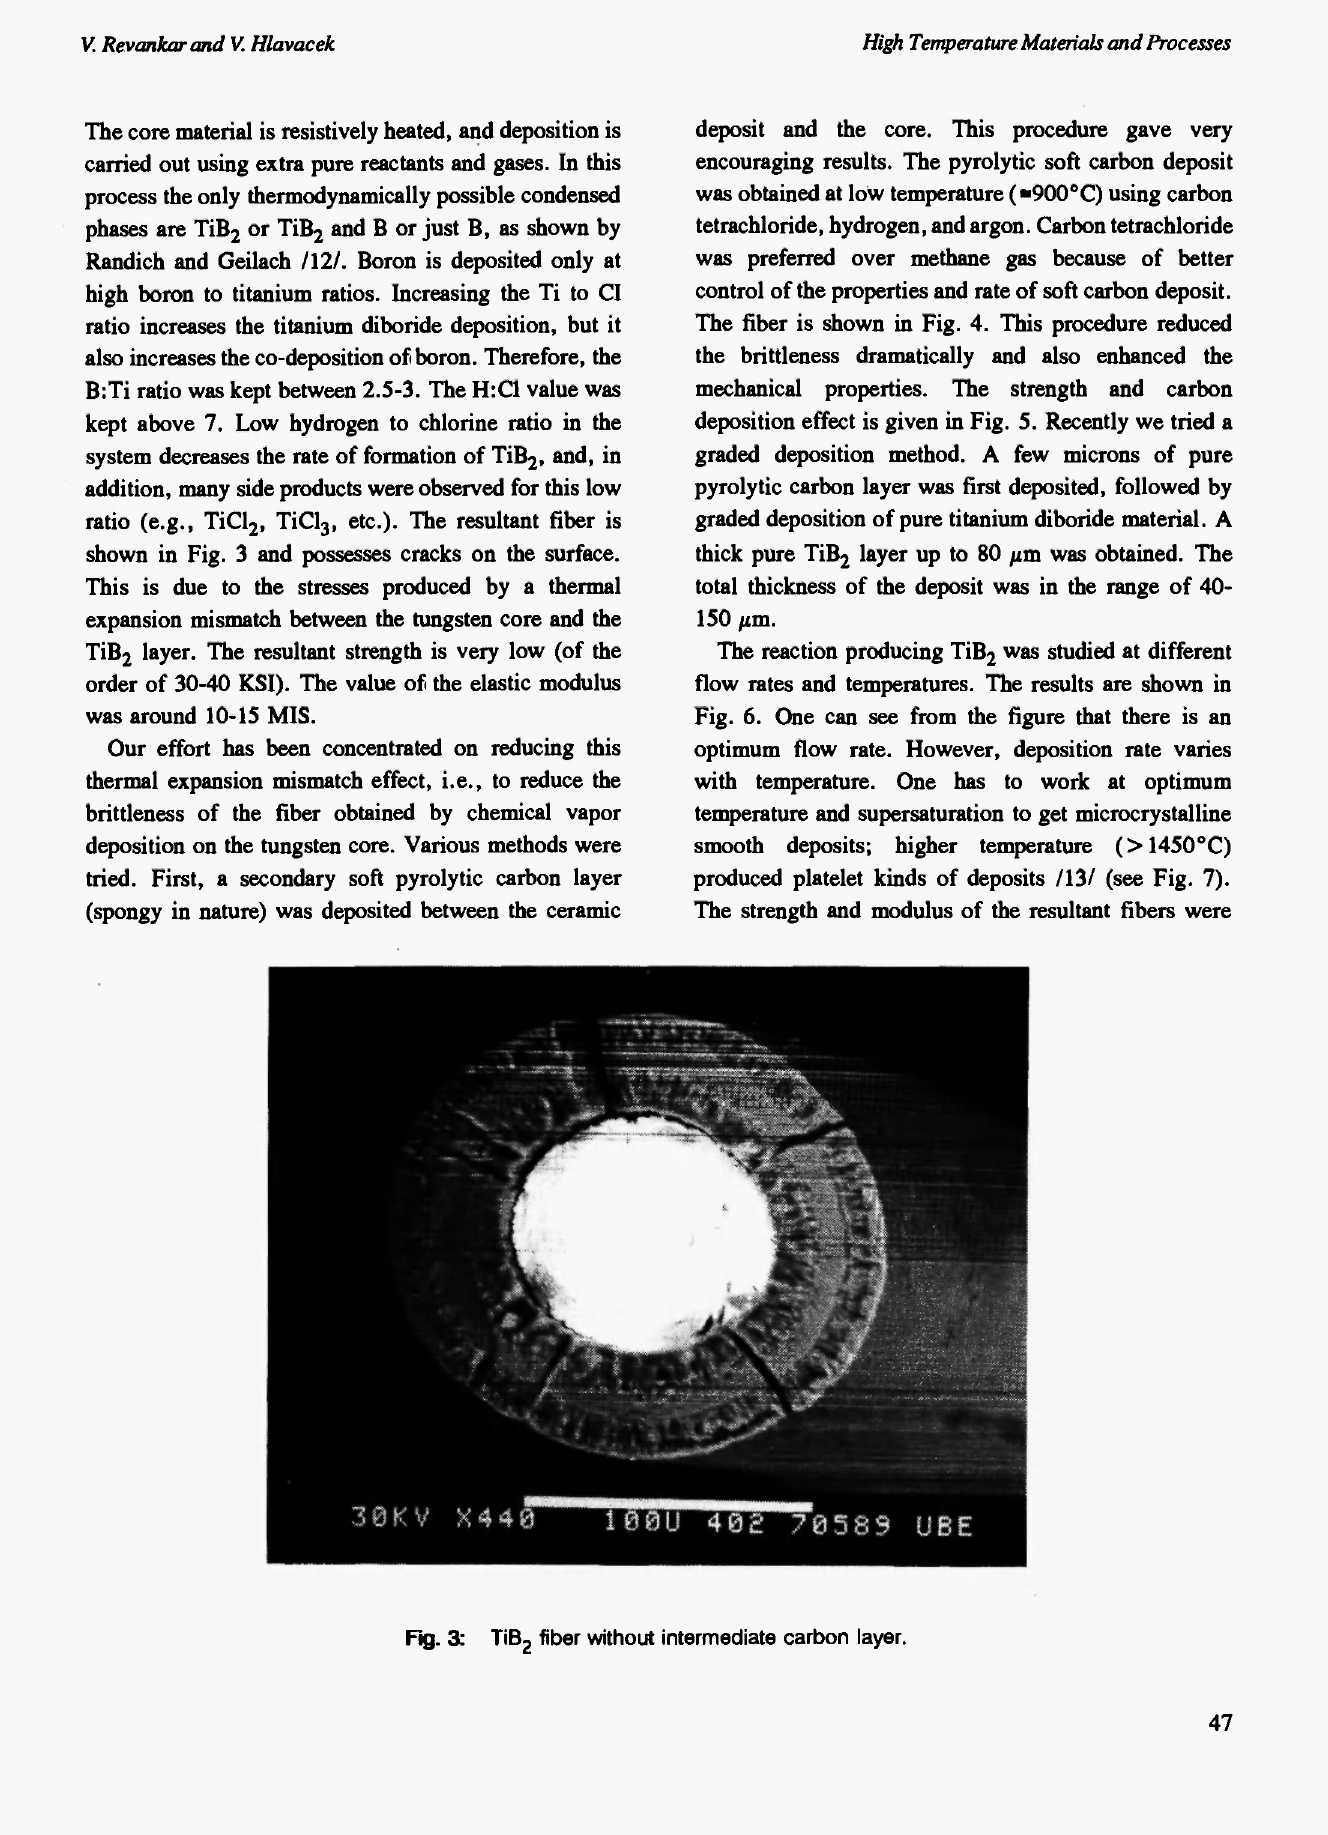
Fig. 3: TiB 2 fiber without intermediate carbon